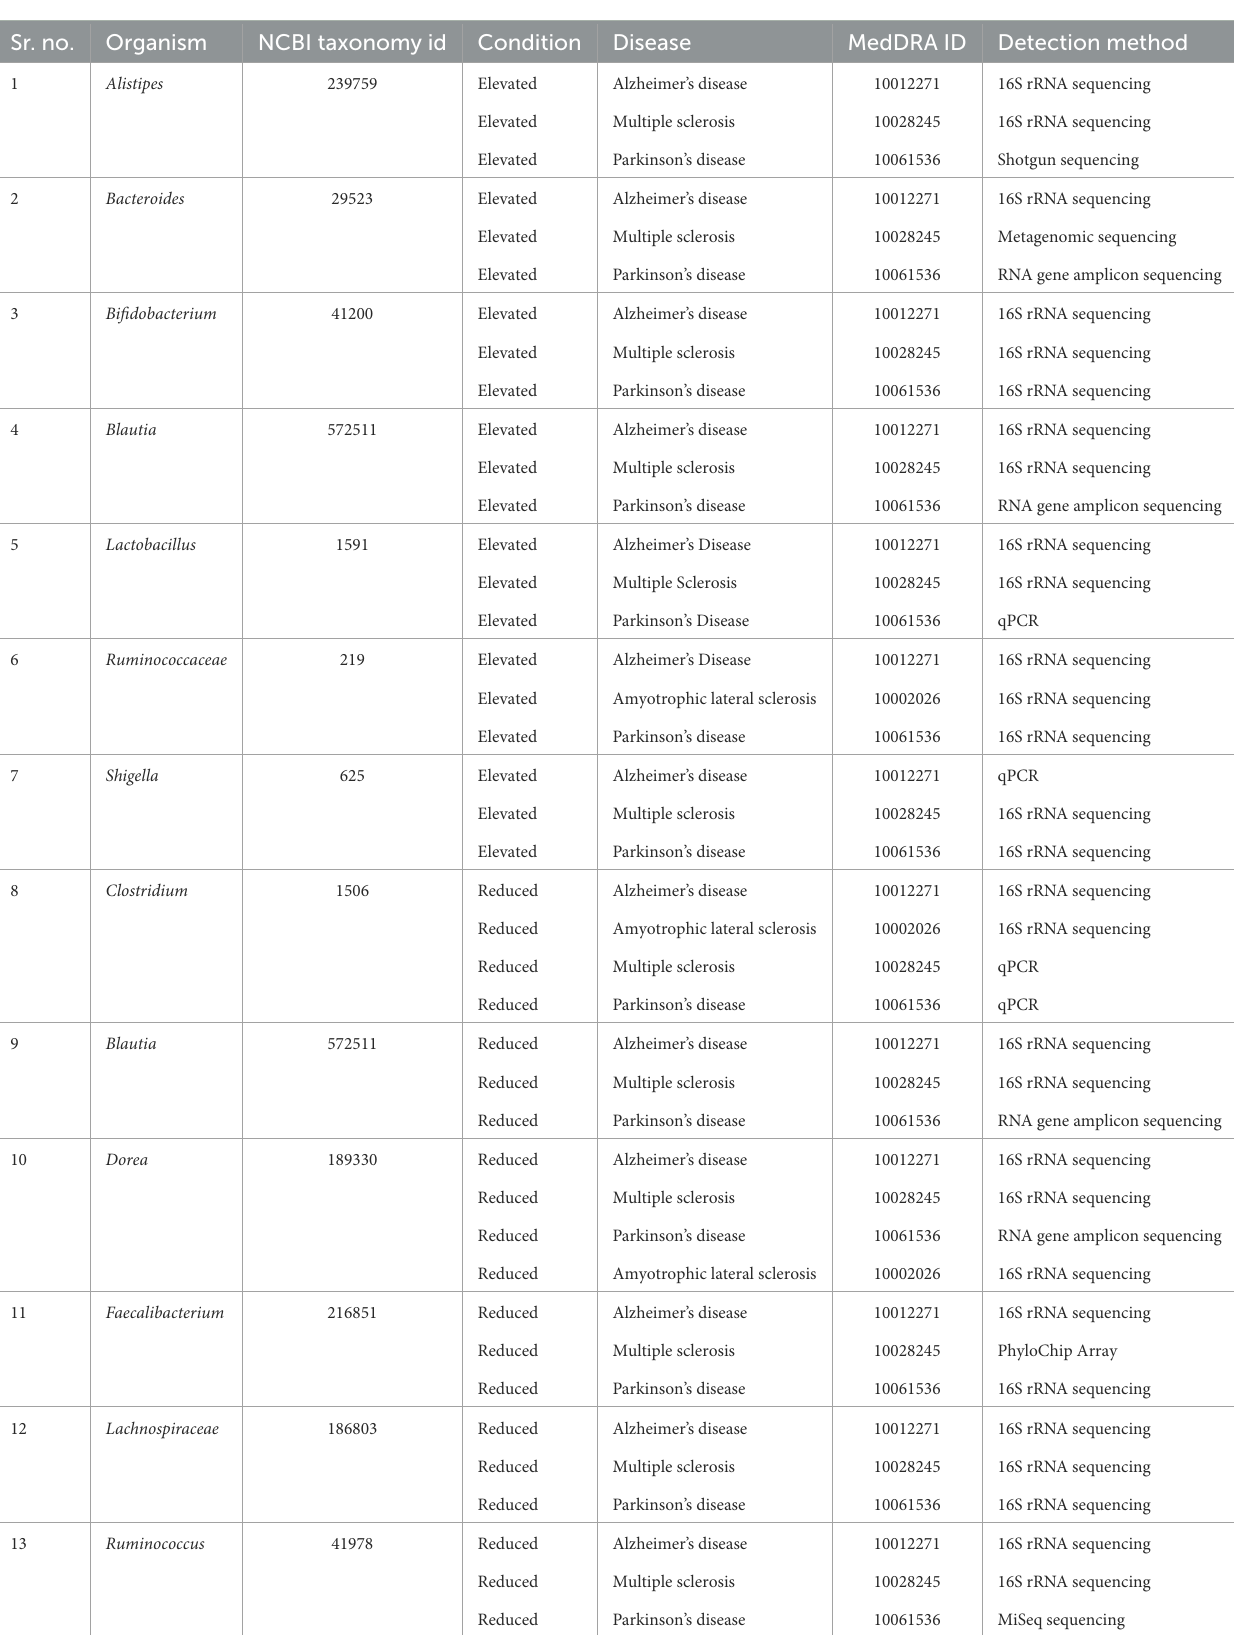
TABLE 1 Commonly affected bacterial groups in Multiple sclerosis, Alzheimer’s disease, Amyotrophic lateral sclerosis, and Parkinson’s disease. Sr.